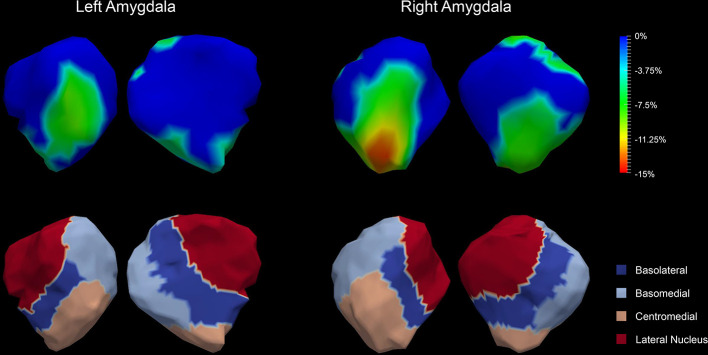
Shape analysis results for the bilateral amygdalas. Statistically significant group comparison results for the amygdalar shape in each hemisphere as well as the corresponding subregion definitions. The color bar represents the percentage of atrophy at a specific vertex in first-episode schizophrenia (FES) relative to healthy control (HC). The bottom panel illustrates the four subregions of the bilateral amygdalas. Two views (left: lateral, right: medial) are presented for each case.